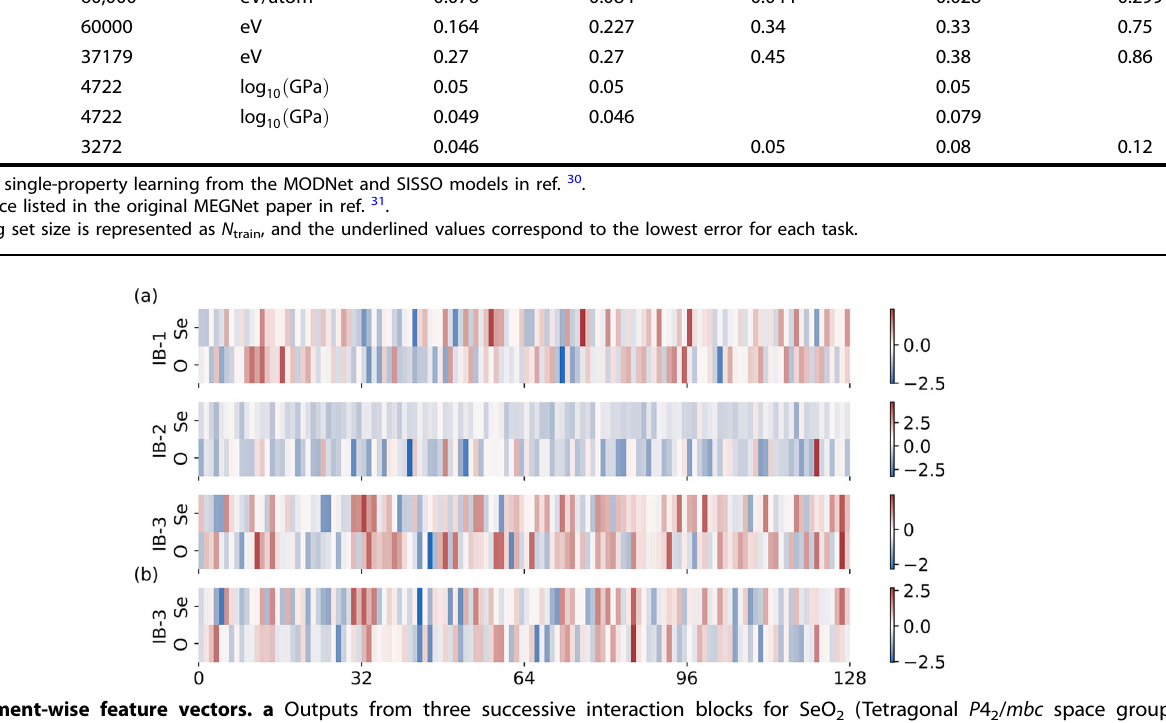
Table 1. Test accuracies in MAEs for the formation energy ( E f ), the bandgap ( E g and nonzero gap E nz ( G VRH ), and the refractive index (n) from ECSTL/ECMTL models and prior works on the materials project data set.